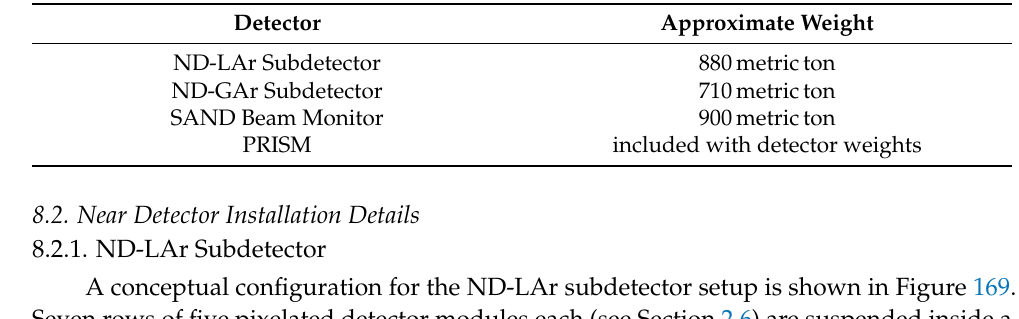
Table 24. Approximate subdetector weight